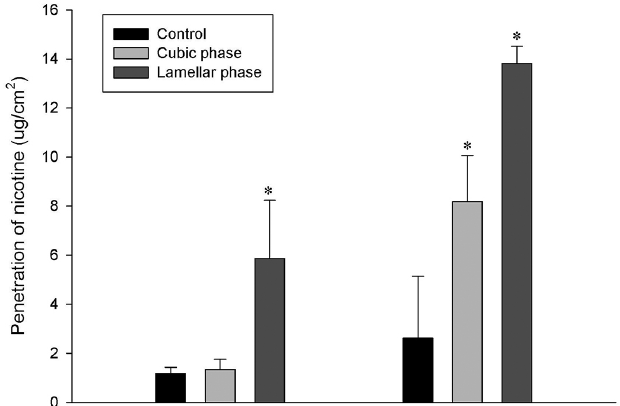
FIGURE 6 - In vitro skin penetration of nicotine at 12 h following topical application using cubic and lamellar phase systems containing 375 μg of nicotine or a control solution (2.5 mg/mL). SC: stratum corneum, [E+D]: epidermis (without SC) plus dermis. Results are represented be means ± S.D. (n = 4). * p < 0.05 compared to